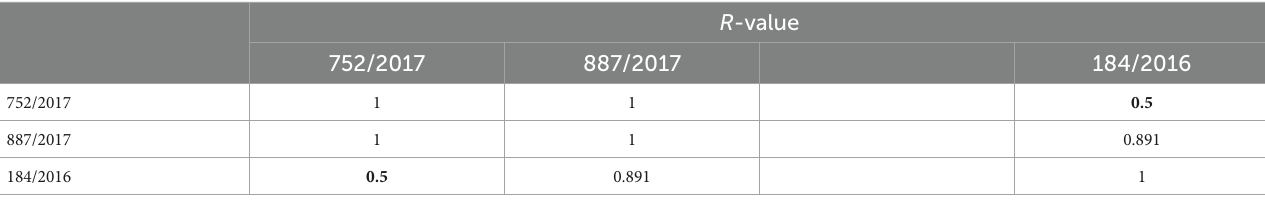
TABLE 2 Antigenic relatedness ( R -value) among the three viruses as determined by the degree of cross-HI activity.